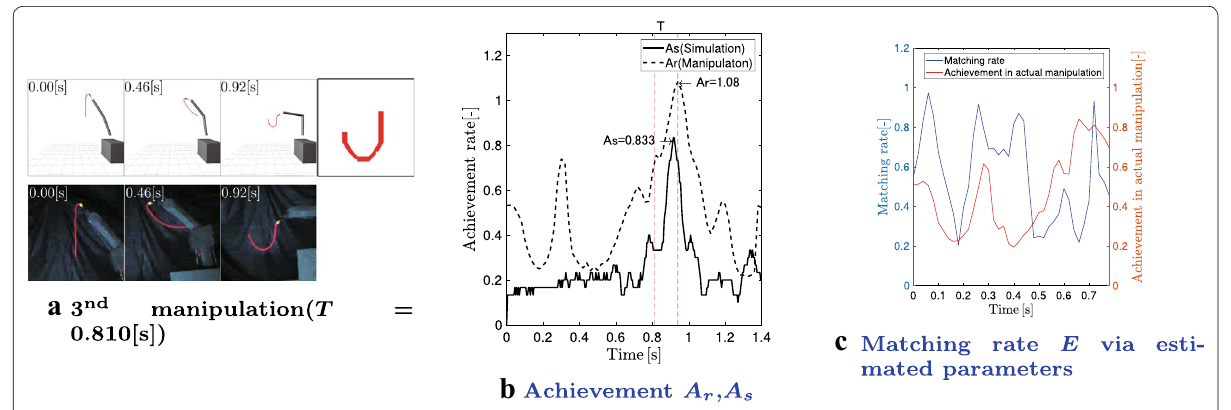
Fig. 14 Manipulation result of desired image of string shape: J